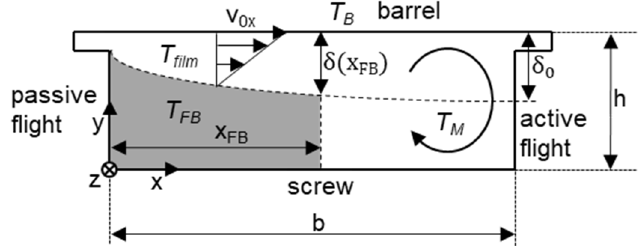
Figure 4. Schematic representation of conventional melting based on Potente [16].